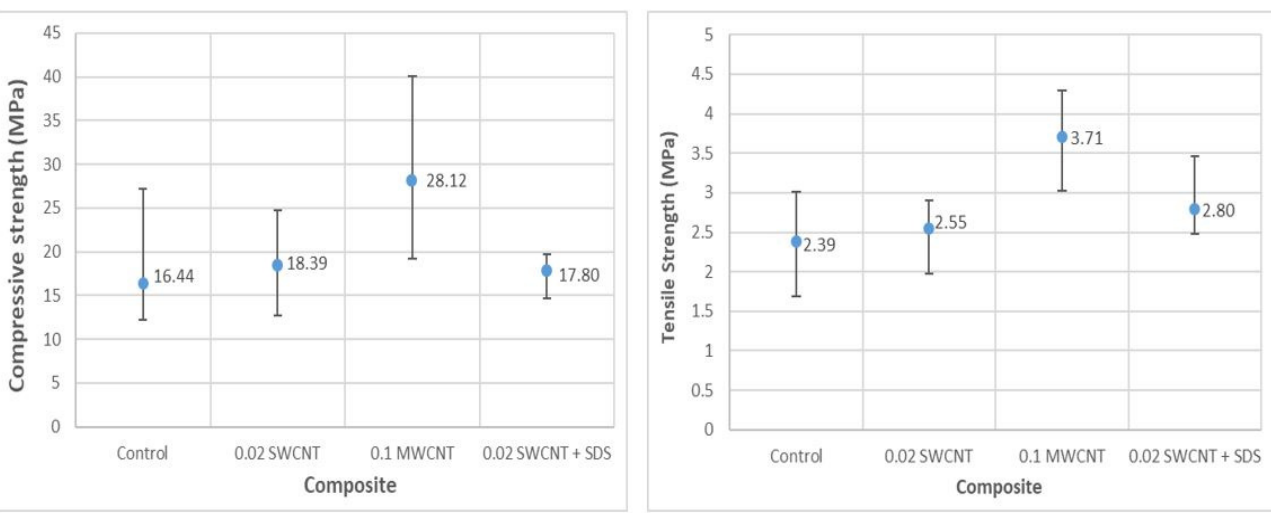
Figure 4. ( a ) RVE of realistic CNT composite; ( b ) RVE of a simplified CNT composite; ( c ) RVE with aligned inclusions.